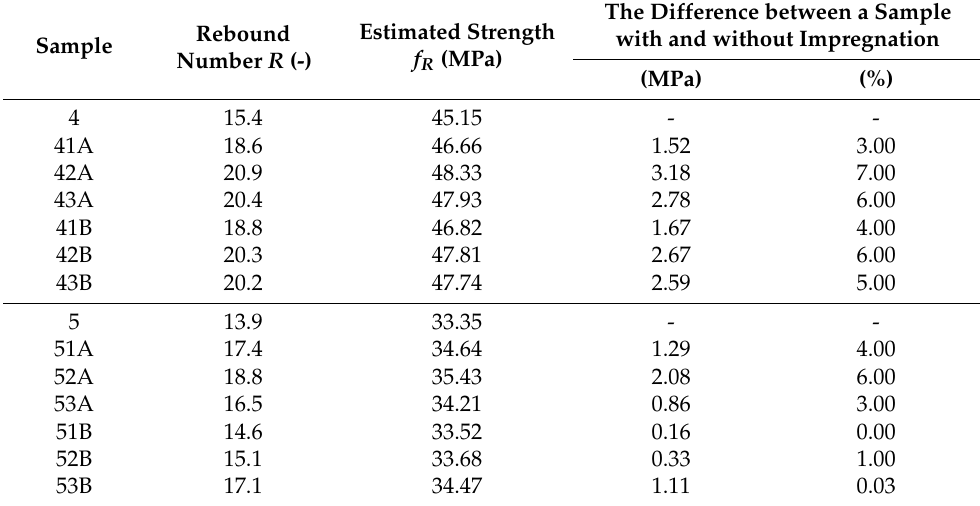
Table 4. Estimated strength of cementitious materials impregnated using hydrophobic agents based on near-surface hardness measurements.